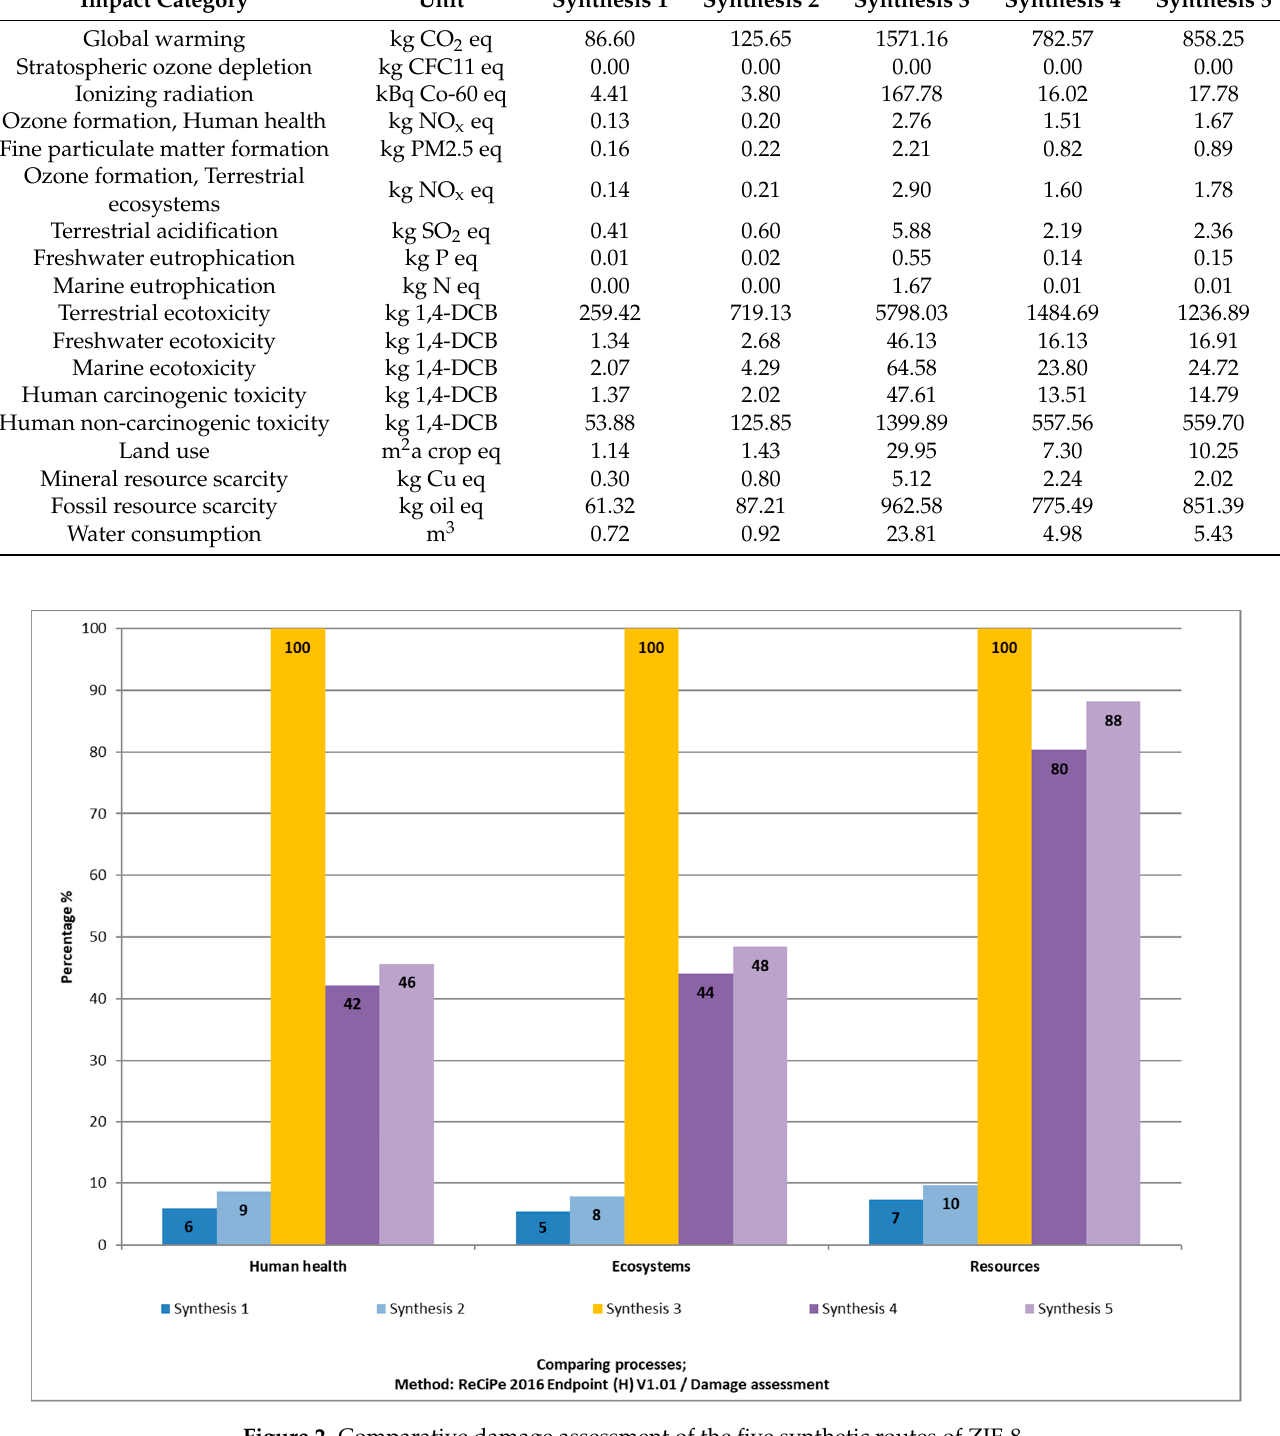
Figure 3. Comparison of the five ZIF-8 synthetic routes per impact category.